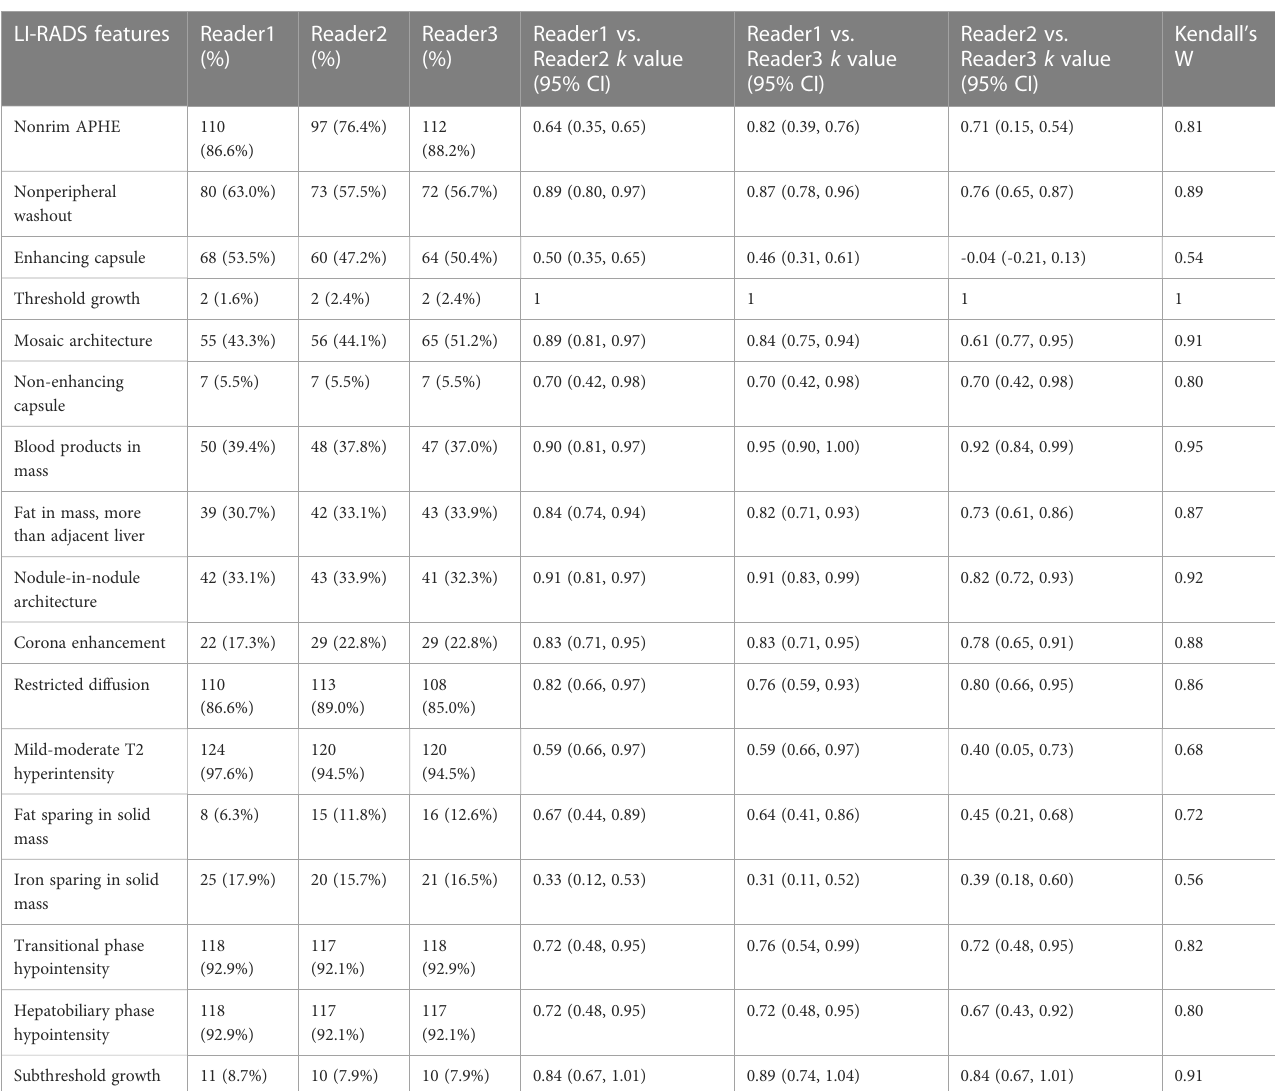
TABLE 2 LI-RADS features consistency of assessment among different